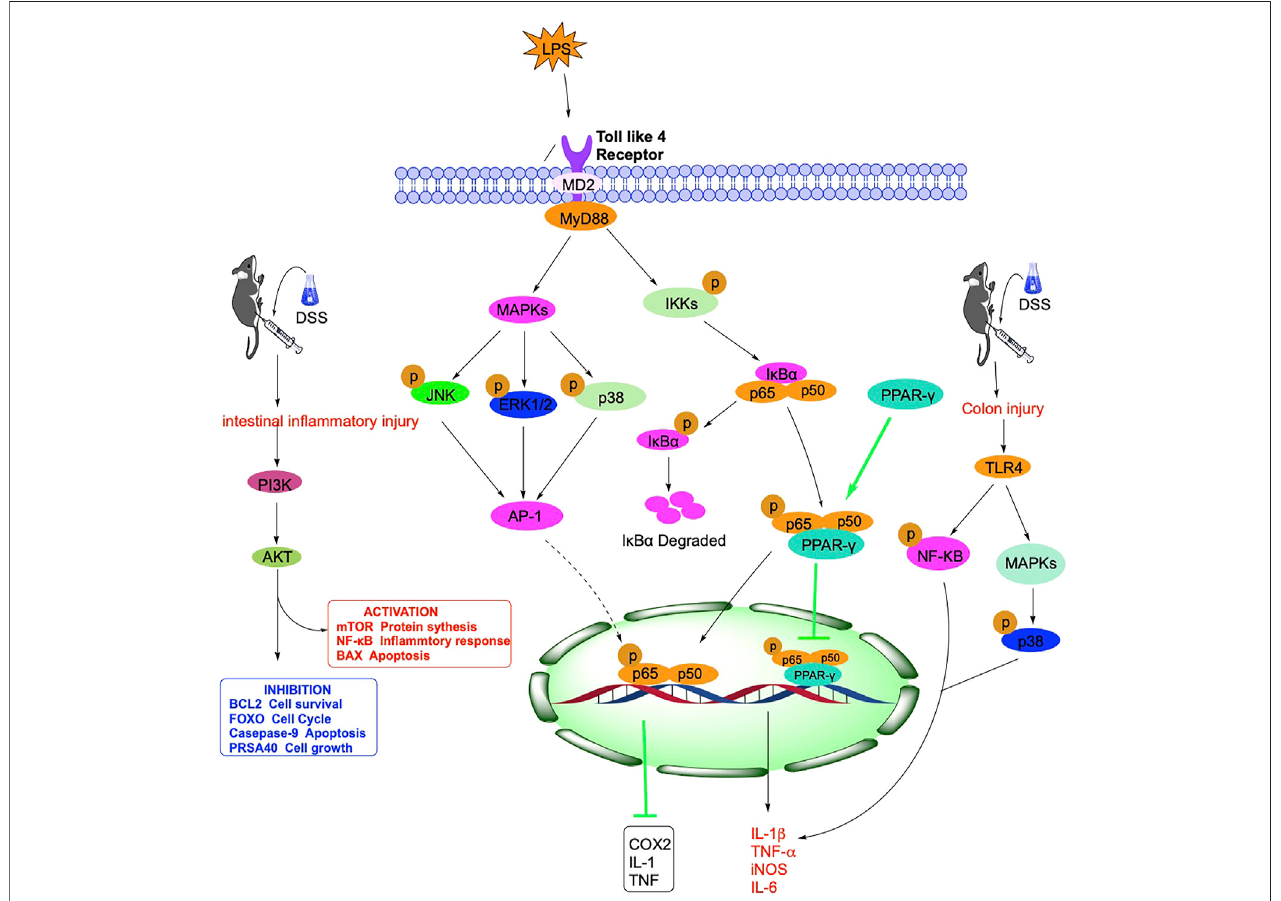
FIGURE 2 | Mechanism of NF- l B, TLR4, PPAR, PI3K and other signaling pathways related in IBD.